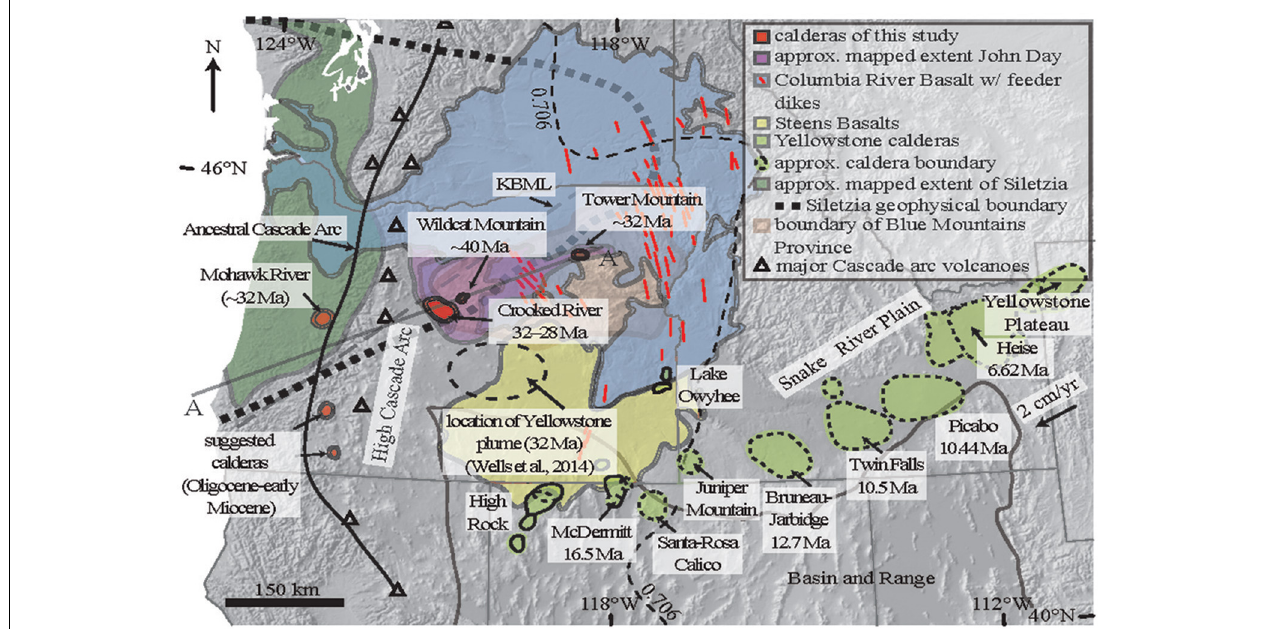
FIGURE 1 | Map showing the location of the newly identified Crooked River, Wildcat Mountain, Tower Mountain, and Mohawk River calderas (McClaughry et al., 2009a,b, 2010; age for Tower Mountain caldera is from Martin Streck, personal communication) in relation to other key features of the Pacific Northwest. Location of the 32Ma Yellowstone plume is derived from G-Plates (Seton et al.,